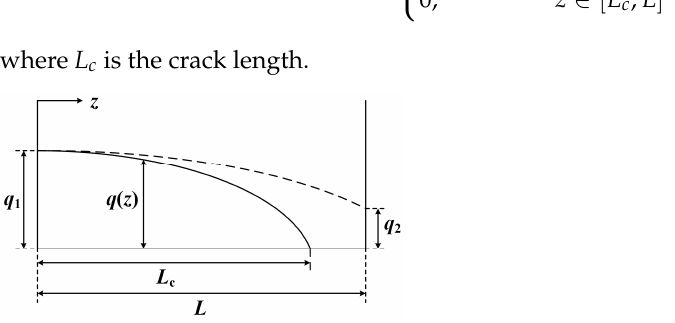
Figure 10. Distribution of crack depth q ( z ).